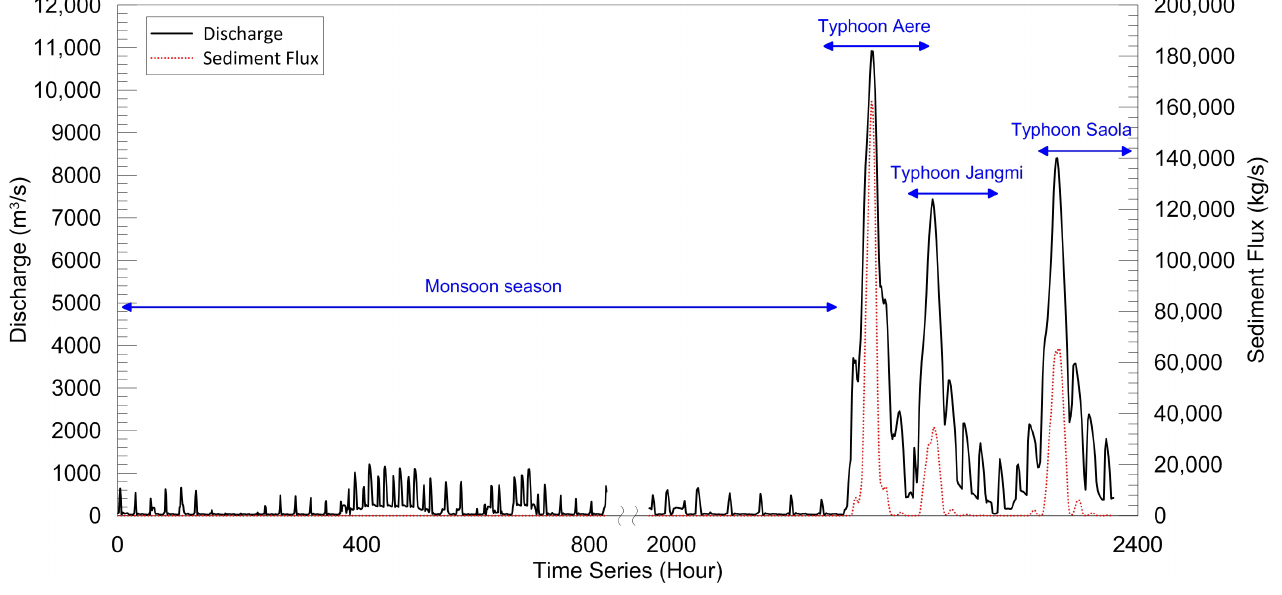
Figure 10. Time series of river discharge and sediment fluxes at the Guandu Bridge. Table 1. Interval from the beginning to the end of each event, and the peak discharge and sediment flux of each